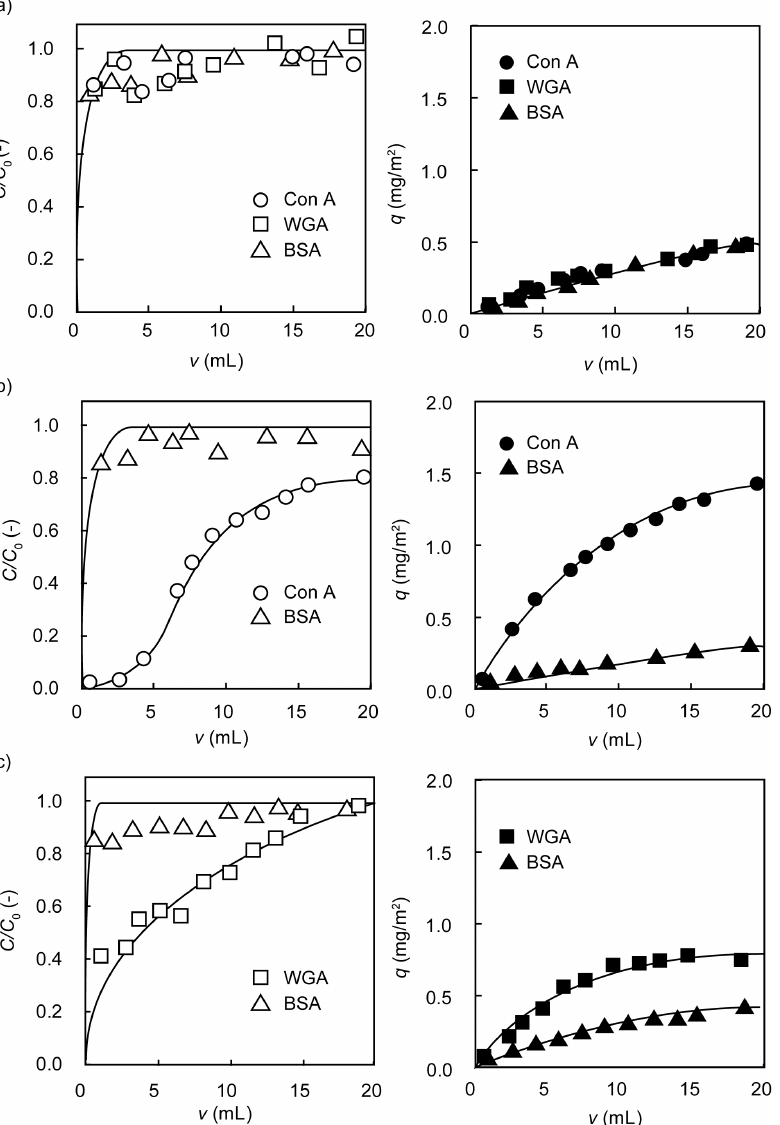
Figure 5. Breakthrough curves and amounts of protein adsorbed on ( a ) polyMA-immobilized; ( b ) poly(Man-MA)-immobilized; and ( c ) poly(GlcNAc-MA)-immobilized